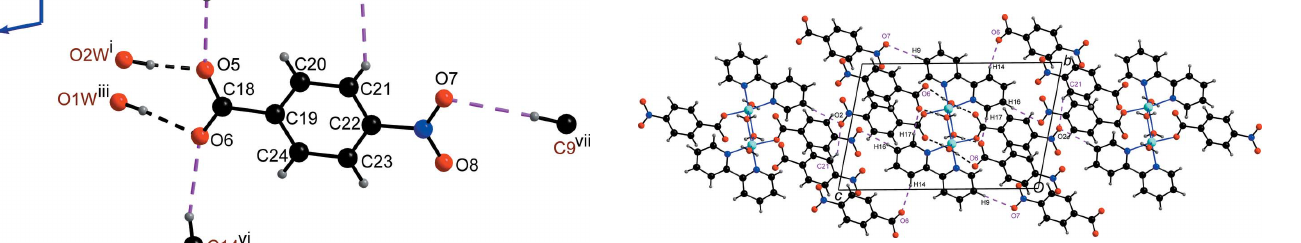
Figure 4 The hydrogen-bonding scheme around the dication showing its linking with eight anions and two cations via O—H (cid:2)(cid:2)(cid:2) O and C—H (cid:2)(cid:2)(cid:2) O hydrogen bonds.